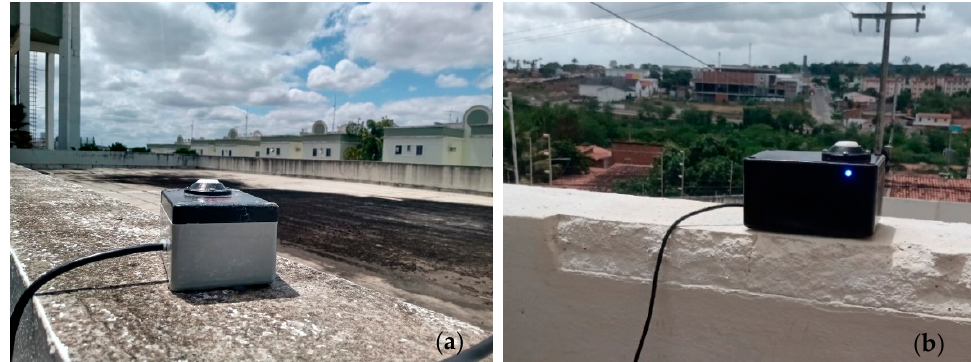
Figure 9. Prototypes installed in Campina Grande, Brazil: ( a ) P01, ( b ) P02.